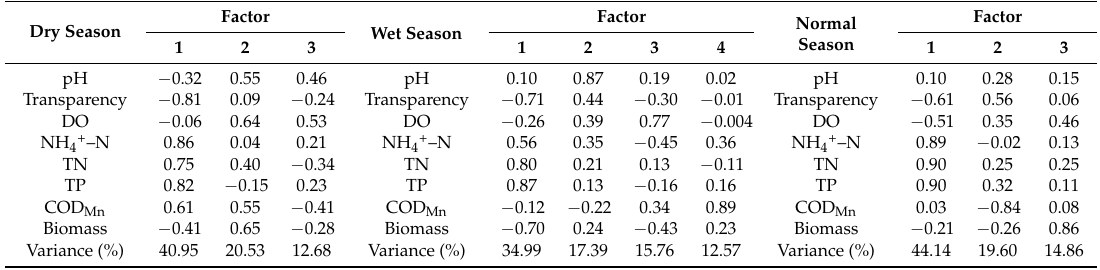
Table 2. Factor loadings of eight variables based on PCA in three